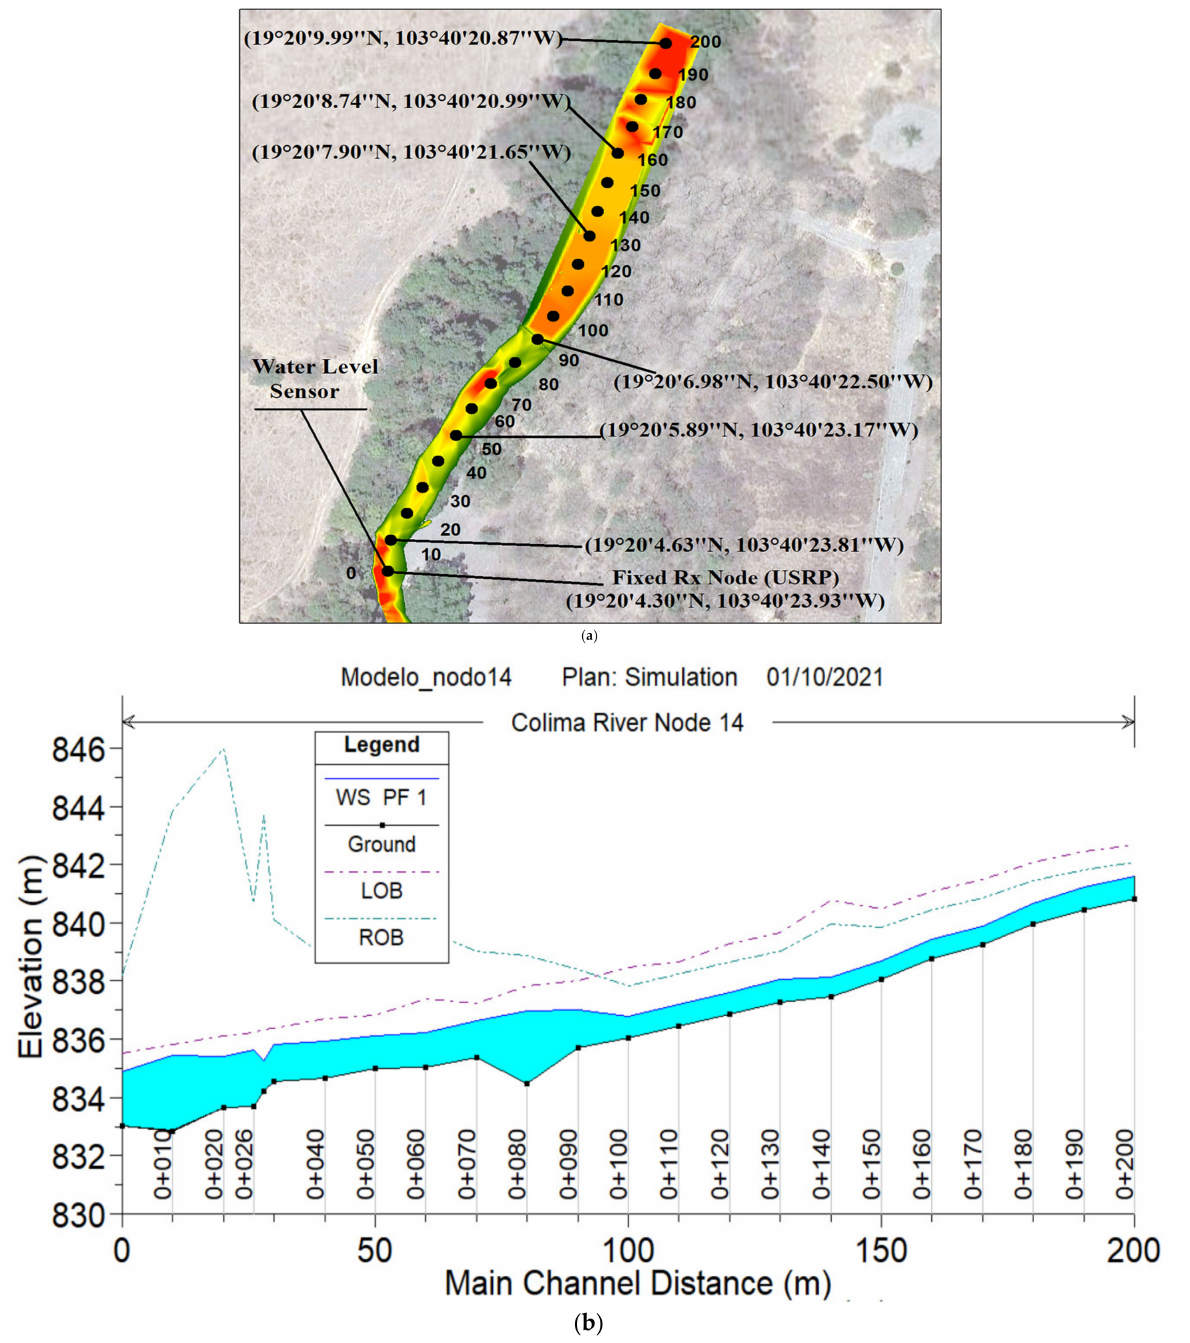
Figure 6. ( a ) Route of the measurement campaign. The receiver node (X310 USRP) is placed at a latitude of 19 ◦ 20 (cid:48) 4.30 (cid:48)(cid:48) N and longitude of 103 ◦ 40 (cid:48) 23.93 (cid:48)(cid:48) W whereas the transmitter LoRa ED is repositioned in steps of 10 m (from 10 m to 130 m). ( b ) Elevation along the river route with respect to the sea level, starting at point 0, 835 m above the sea level, and the last point considered in the propagation model was at 0 + 130 m, 838 m above the sea level. Where the LOB and the ROB labels are the Left and Right Over Bank, respectively, and the WS PF1 blue line is the surface of the river at the time to carry out the measurement